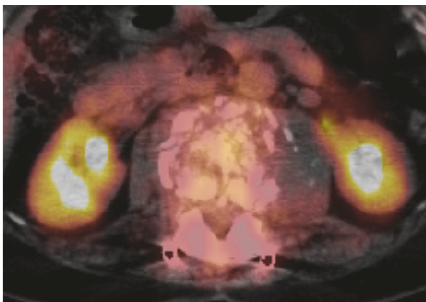
Figure 4: Uptake for metastases in the posterior element was not observed in